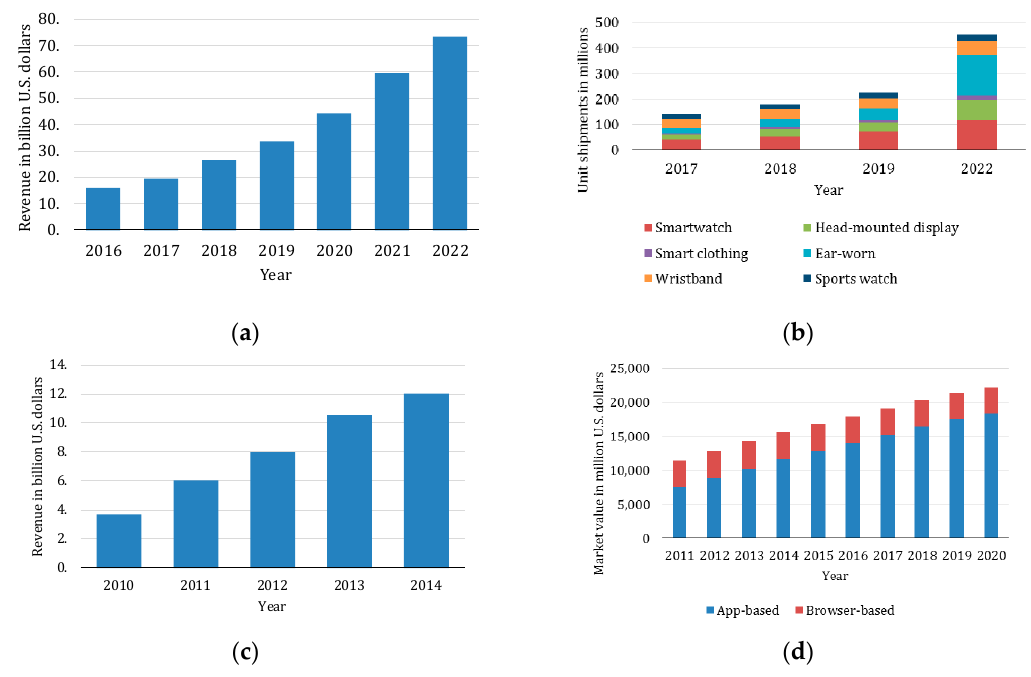
Figure 4. Trends of interconnectivity: ( a ) wearable device sales revenue worldwide from 2016 to 2022; ( b ) forecast unit shipments of wearable devices worldwide from 2017 to 2022; ( c ) social gaming revenue worldwide from 2010 to 2014; ( d ) value of the social gaming industry worldwide from 2011 to 2020.